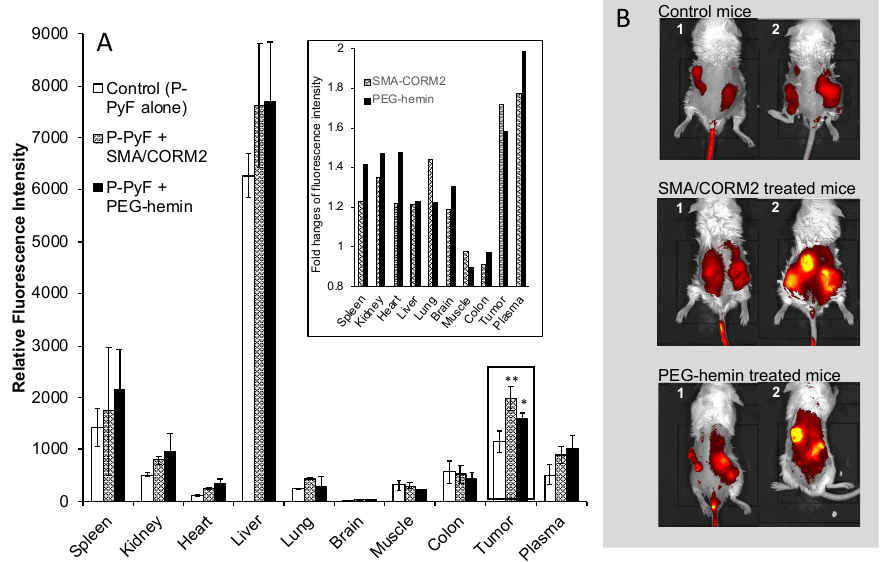
Figure 2. Effect of CO generators on the body distribution of pHPMA [ N -(2-hydroxypropyl)methacrylamide copolymer]-conjugated pyropheophorbide-a (P-PyF) in C26 tumor-bearing mice. PEG-hemin was injected i.v. 24 h before, and SMA/CORM2 was injected i.v. 2 h before the administration of P-PyF (5 mg/kg, PyF equivalent). At 24 h after P-PyF administration, two mice in each group (1 and 2) underwent imaging by an IVIS in vivo imaging system ( B ), followed by the quantification of a P-PyF amount in each tissue by detecting the fluorescence from PyF ( A ); the inset of ( A ) shows the fold changes of fluorescence from PyF. *, p < 0.05; **, p < 0.01. The data are means ± SD, n =